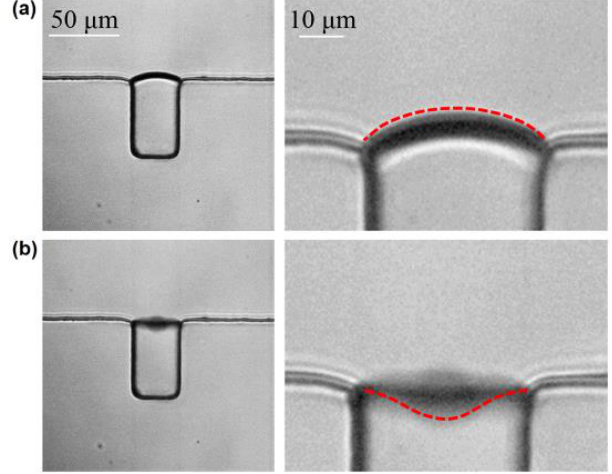
Figure 4. The membrane deformation of the oscillating bubble. ( a ) No deformation of the oscillating microbubble is observed without ultrasound irradiation. ( b ) The deformation of the bubble membrane is approximately 16.23 μm when the input voltage is 144 Vpp.